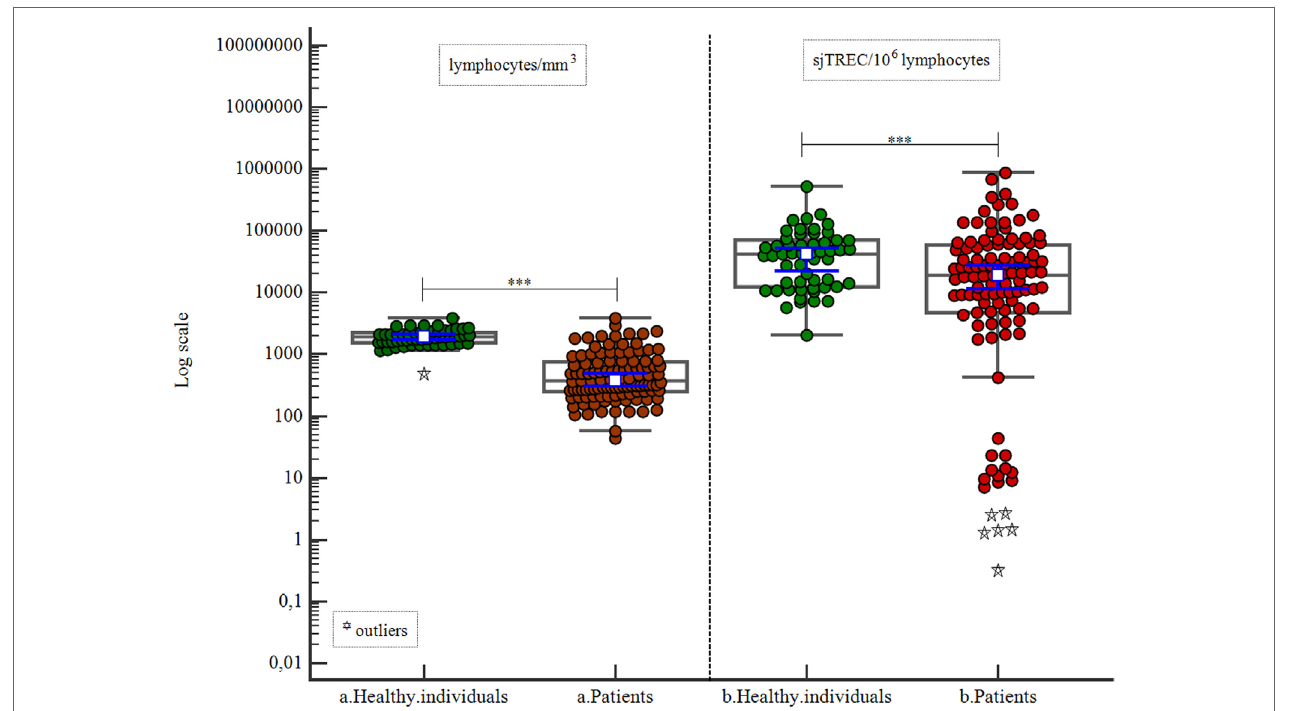
FigUre 1 | Correlation of lymphocyte count and signal joint TREC (sjTREC) count between healthy individuals and patients. FigUre 2 | Correlation between age and signal joint TREC (sjTREC) count.